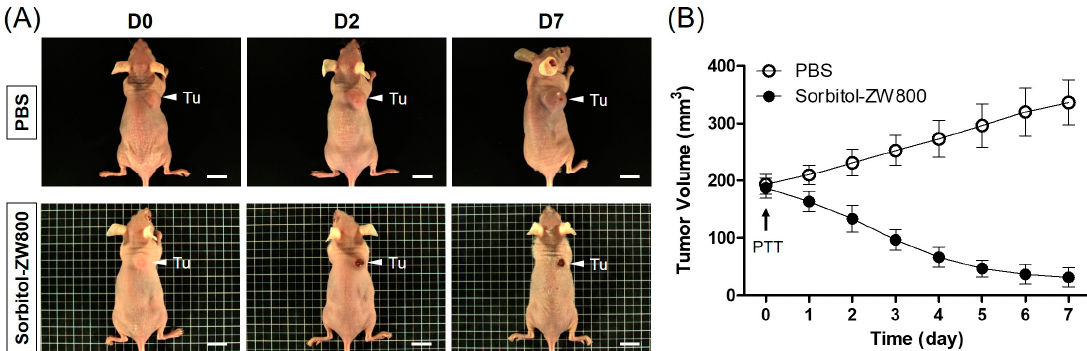
Figure 5. ( A ) In vivo NIR photothermal therapeutic efficacy. Representative photos of tumor size changes treated with 2 h post-injections of PBS and sorbitol–ZW800 (10 nmol, 0.4 mg/kg), respectively, followed by 808 nm laser irradiation (1.1 W/cm 2 ) for 5 min. ( B ) Tumor growth rates of each treatment group were monitored for 7 days. Data are expressed as mean ± S.D. of the three independent experiments. Abbreviation: Tu, tumor; and PTT, photothermal therapy. Scale bars = 1 cm.